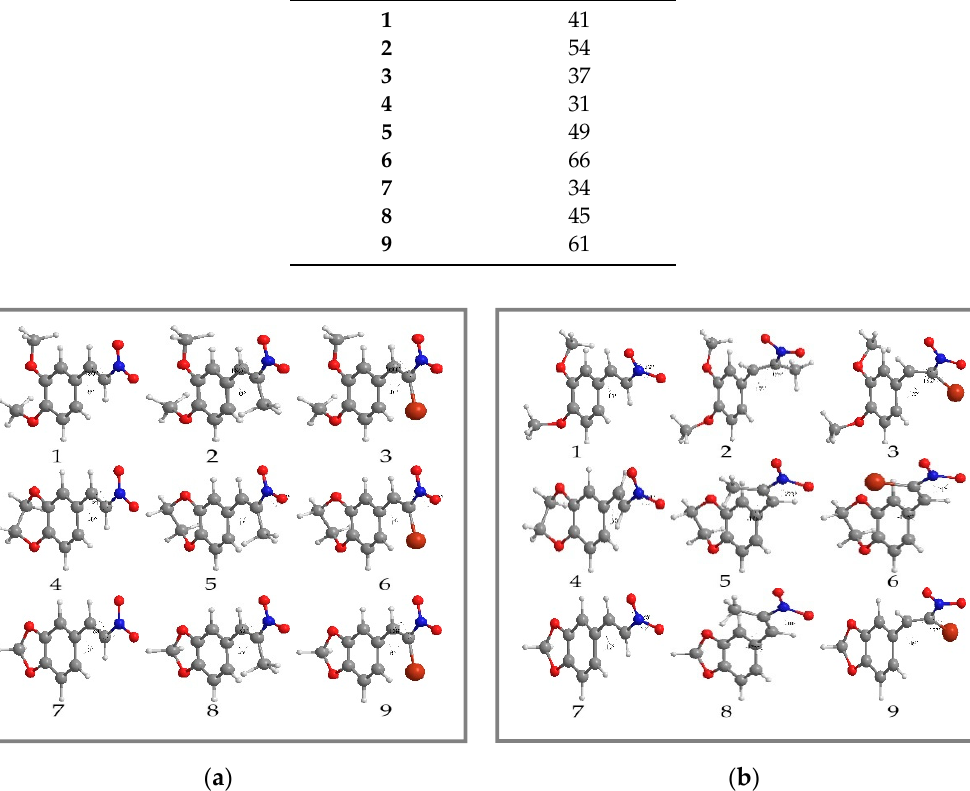
Figure 8. ( a ) Conformation for each compound in the most stable geometries before molecular docking; ( b ) After molecular docking. The colors represent the element or atom (Red: Oxygen; Blue: Nitrogen; White: Hydrogen; Gray: Carbon; Dark red: Bromine)